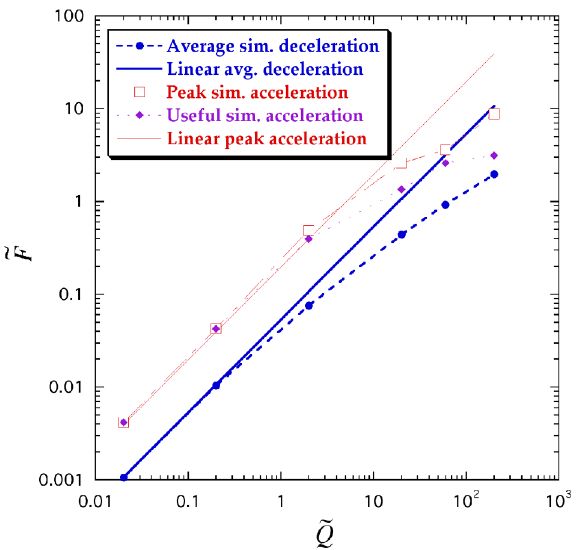
FIG. 8. (Color) The average normalized energy loss rate of ~ FF (cid:4) e jh E ij =m c! of a Gaussian-current electron beam z e p dec (cid:4) 1 : 1 ; ~ aa (cid:4) 0 : 2 , as a function of ~ QQ , from linear (cid:3) with k p z theory (solid bold line) and self-consistent PIC simulation (circles), the peak accelerating field behind the beam, ~ FF j =m c! e j E , from linear theory (solid fine line) and z; max e p PIC simulation (squares), and the useful field for acceleration